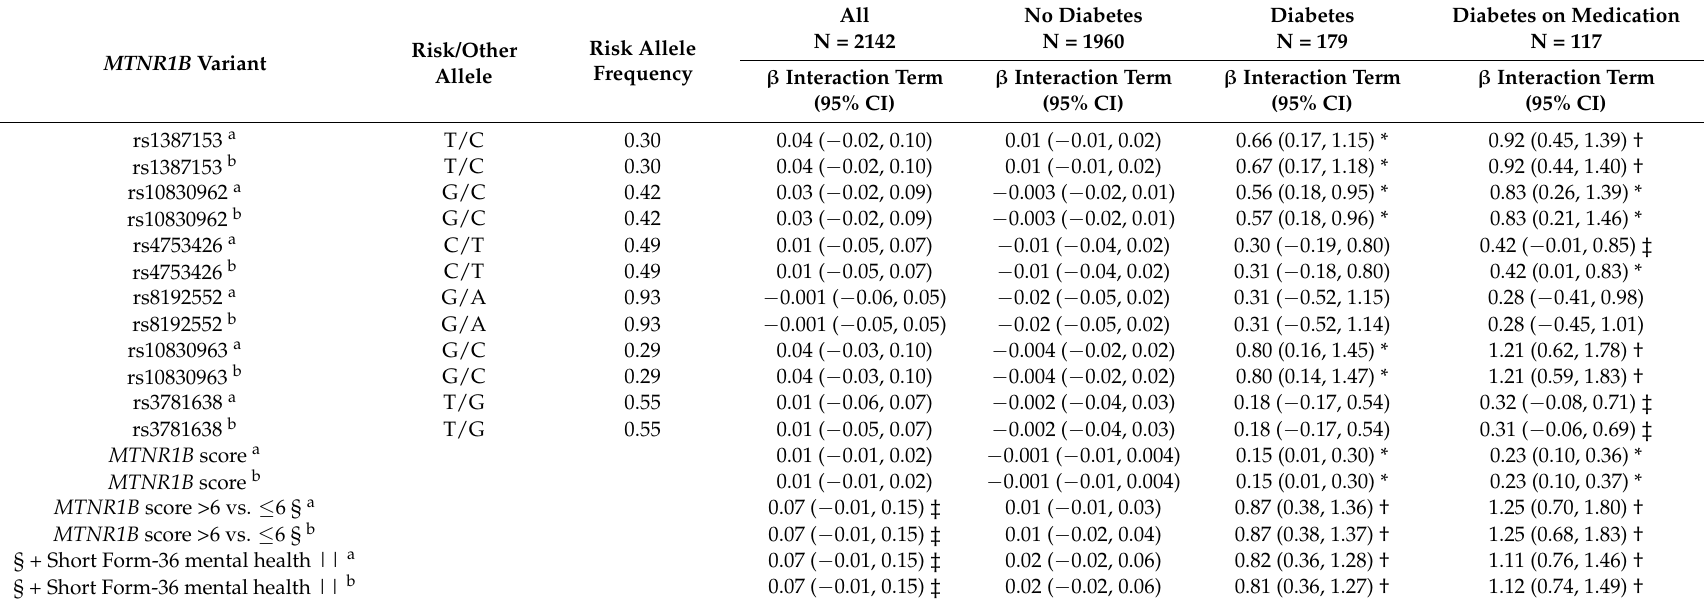
Table 3. Interaction between MTNR1B variants (single/score) and night-time road traffic noise (10 dB difference) on change in HbA1c, in non-movers.